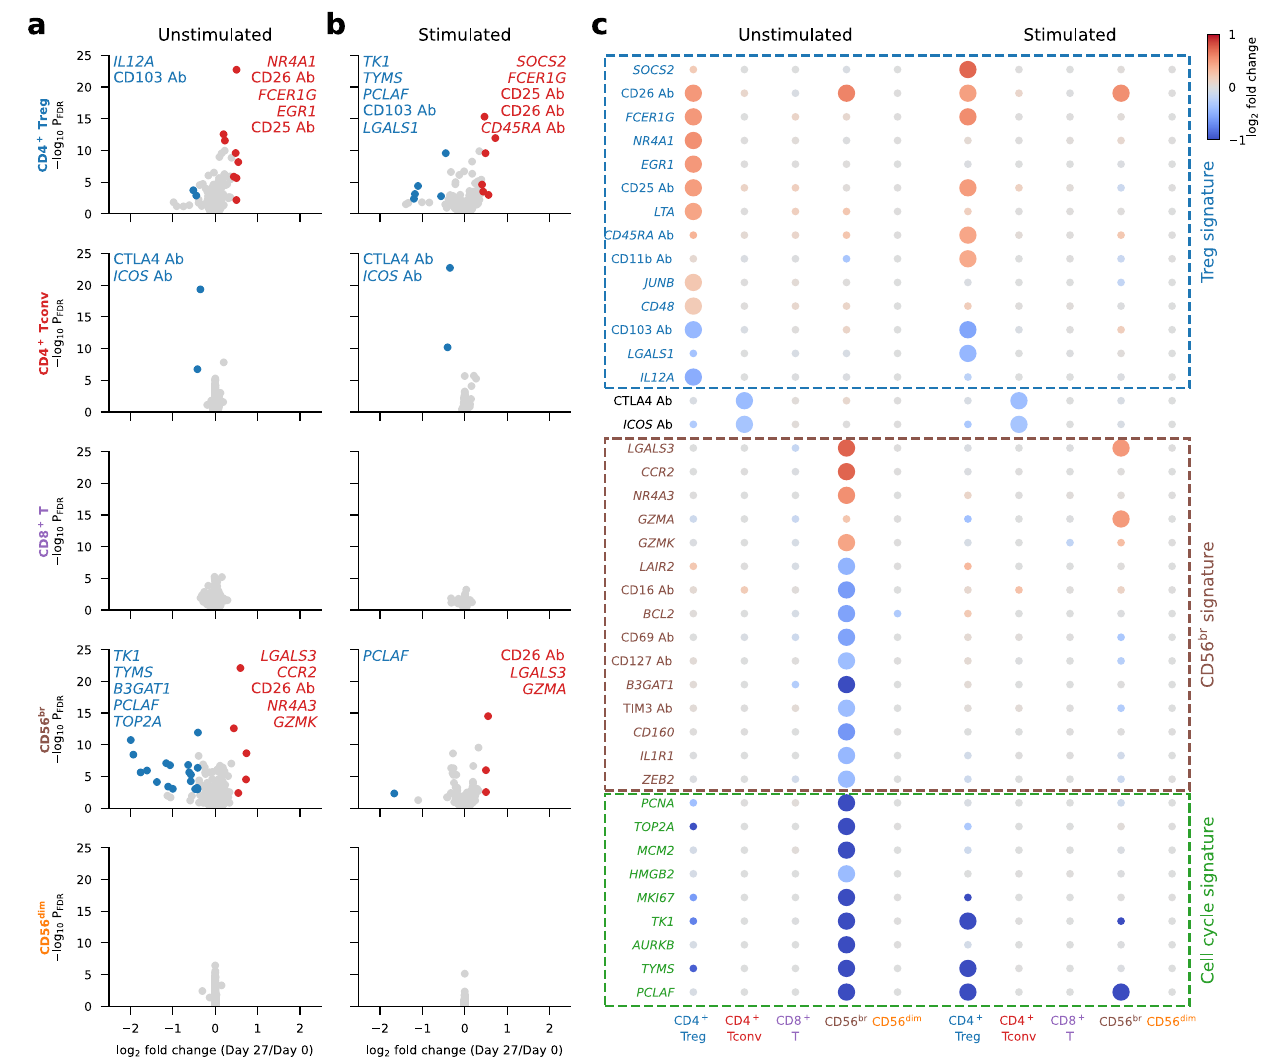
Fig. 5 | IL-2 treatment selectively modulates gene expression of CD25 hi Tregs and CD56 br NK cells at Day 27. a , b Volcano plots depicting gene expression changes between Day 0 and Day 27 for the fi ve assessed immune populations, for unstimulated ( a ) and stimulated ( b ) cells. Signi fi cantly differentially expressed genes are coloured in red (upregulated genes) or blue (downregulated genes). Names of the top fi ve up- and downregulated genes as de fi ned by fold change are labelled on each panel. c Differential expression of Day 27 signature genes. Day 27 signature genes are de fi ned as the 40 genes that are signi fi cantly differentially